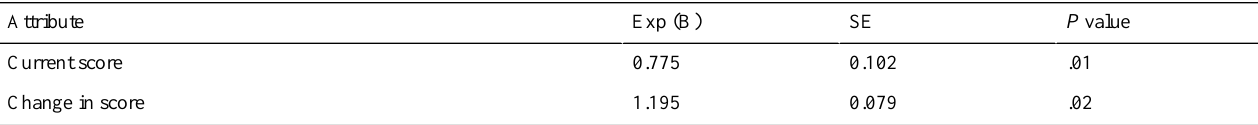
Table 1. Cox proportional-hazard model for future postings on the suicide watch forum. N=6751.